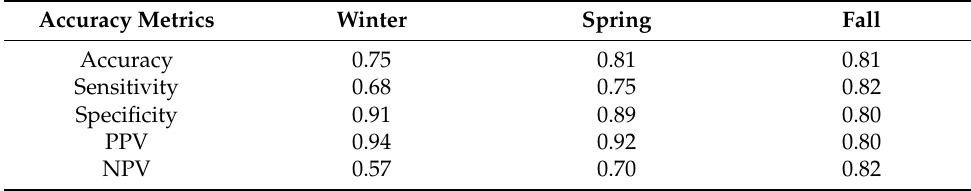
Figure 4. Area (ha) of the bay with Eelgrass and No Eelgrass cover, as predicted from SVM classifi- cations of satellite imagery. Error bars incorporate satellite and UAV classification error.